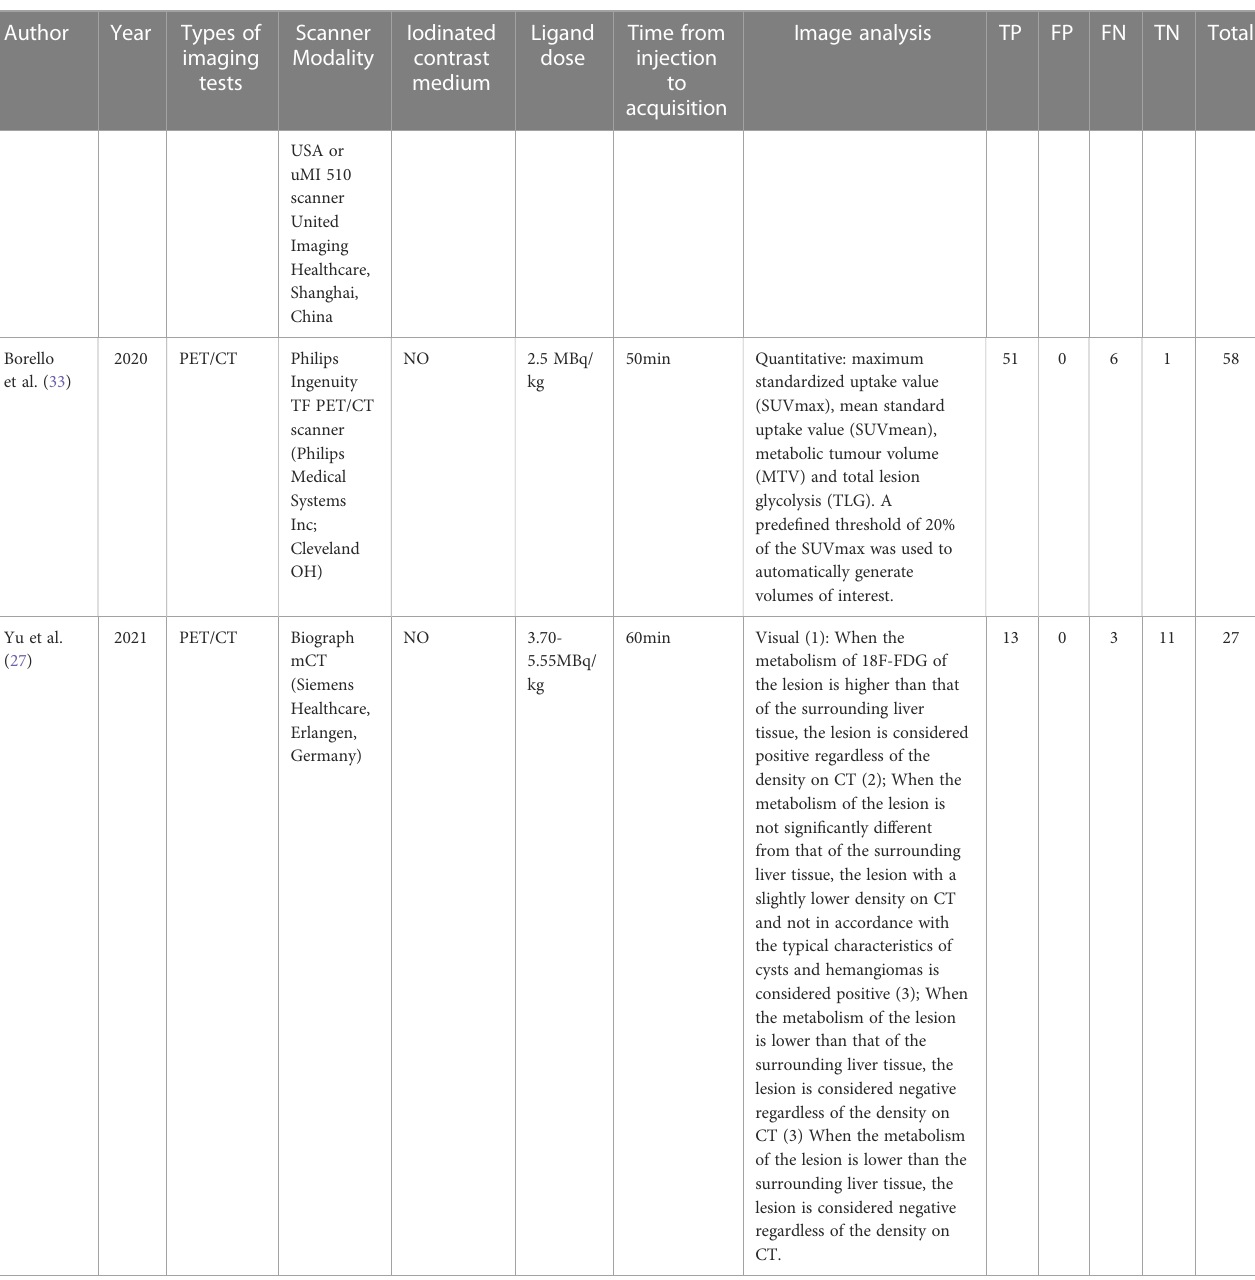
(Figure 3). The pooled sensitivity of [18F]FDG PET/MRI were 0.84 (95% CI, 0.77-0.89) and speci fi city were 1.00 (95%CI, 0.32-1.00) (Figure 4). The sensitivity of the two tests didn ’ t differ signi fi cantly ( P = 0.58),and the speci fi city of the two tests also didn ’ t differ